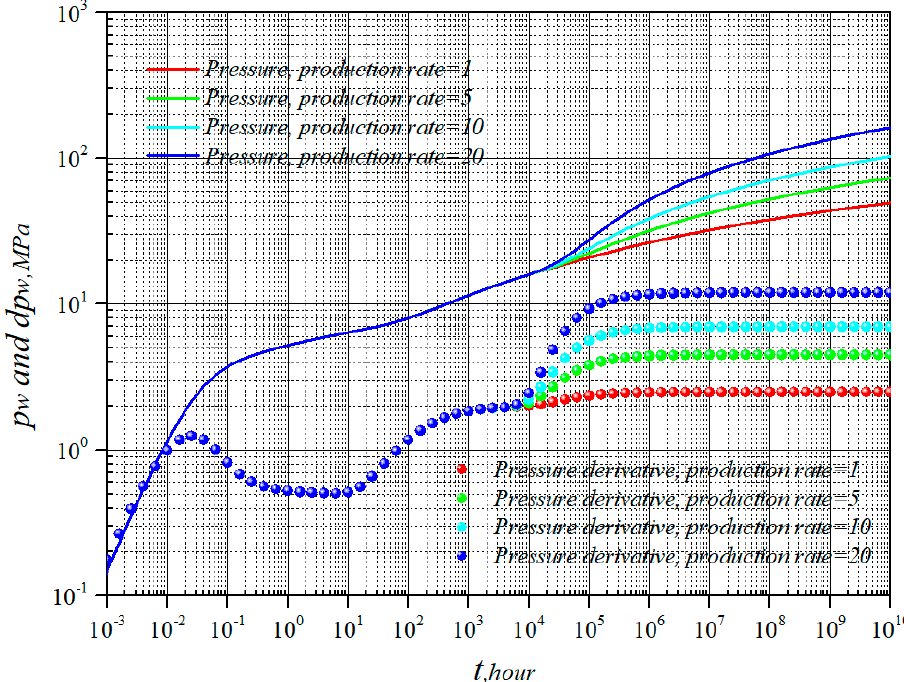
Figure 7. Effect of neighboring well’s production rate on the tested well’s pressure behaviors in the multi-well